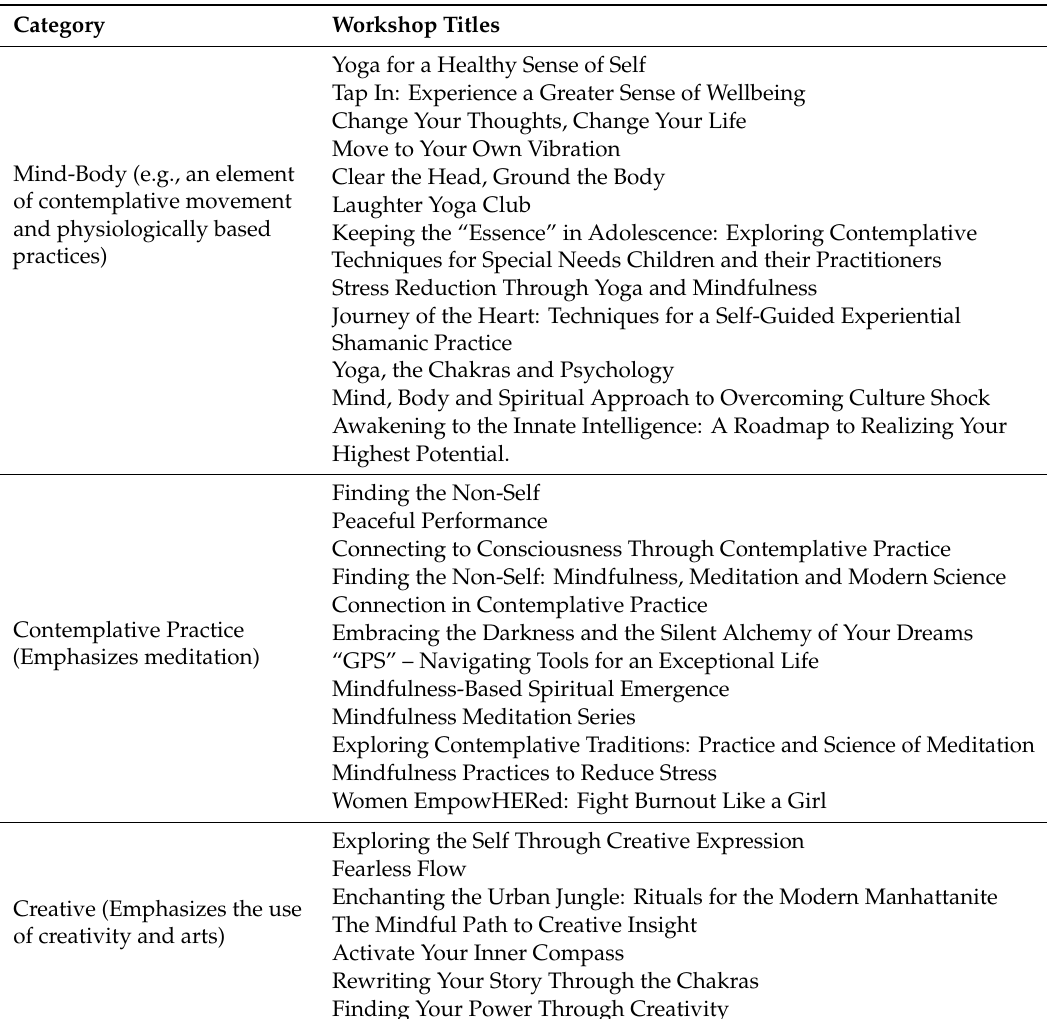
Table 1. Categories and Titles of Previous SMB Wellness Center